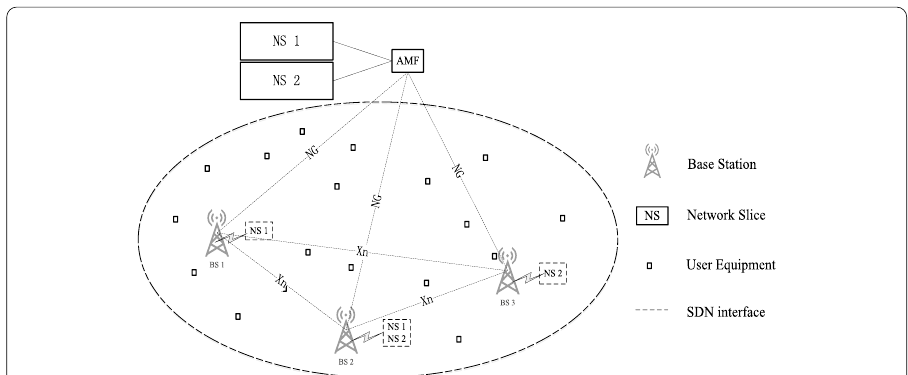
Fig. 1 Network slice-based network architecture. We consider a slice-based mobile network model as shown in this figure, which consists of M base stations and N network slices. Different slices share system transmission resources, including wireless transmission bandwidth and power at the RAN and slice capacity at the CN. A slice may cover multiple BSs, one BS may also be covered by multiple slices, and transmission resources in the BS are allocated to multiple